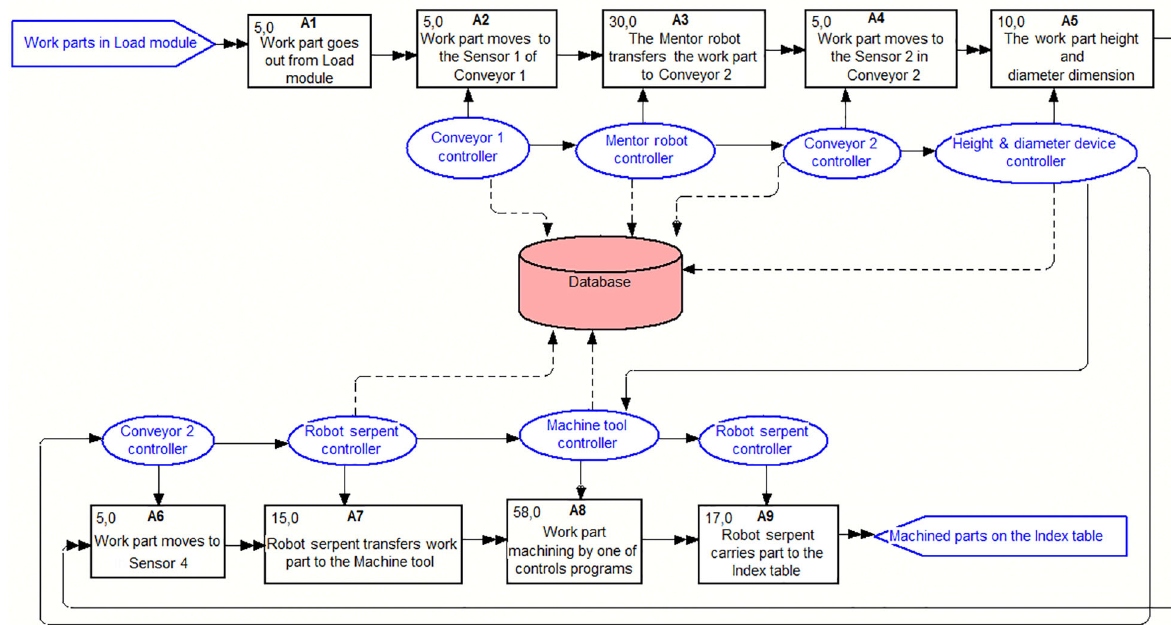
Fig. 7. The process model of the manufacturing